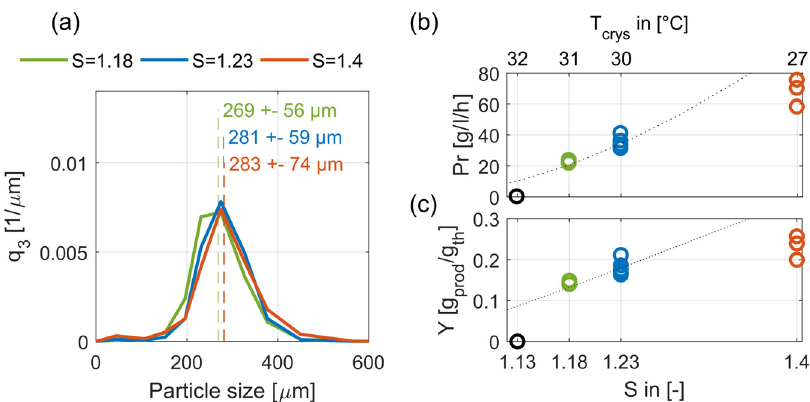
Figure 9. Mean steady-state crystal size distributions, q 3 , with their respective mean values and standard deviations ( a ), productivities, Pr ( b ), and yields, Y ( c ), for four different supersaturations, S = 1.40, 1.23, 1.18, and 1.13, and the same saturation temperature and volumetric flowrate. The respective crystallization temperatures, T crys = 27, 30, 31, and 32 °C, are indicated. The dotted lines (b and c) represent the change with respect to the operation point at T crys = 30 °C, assuming the withdrawn product mass is proportional to the growth rate [19]. Given results are from crystallizer C1 for Exps. 1–3.